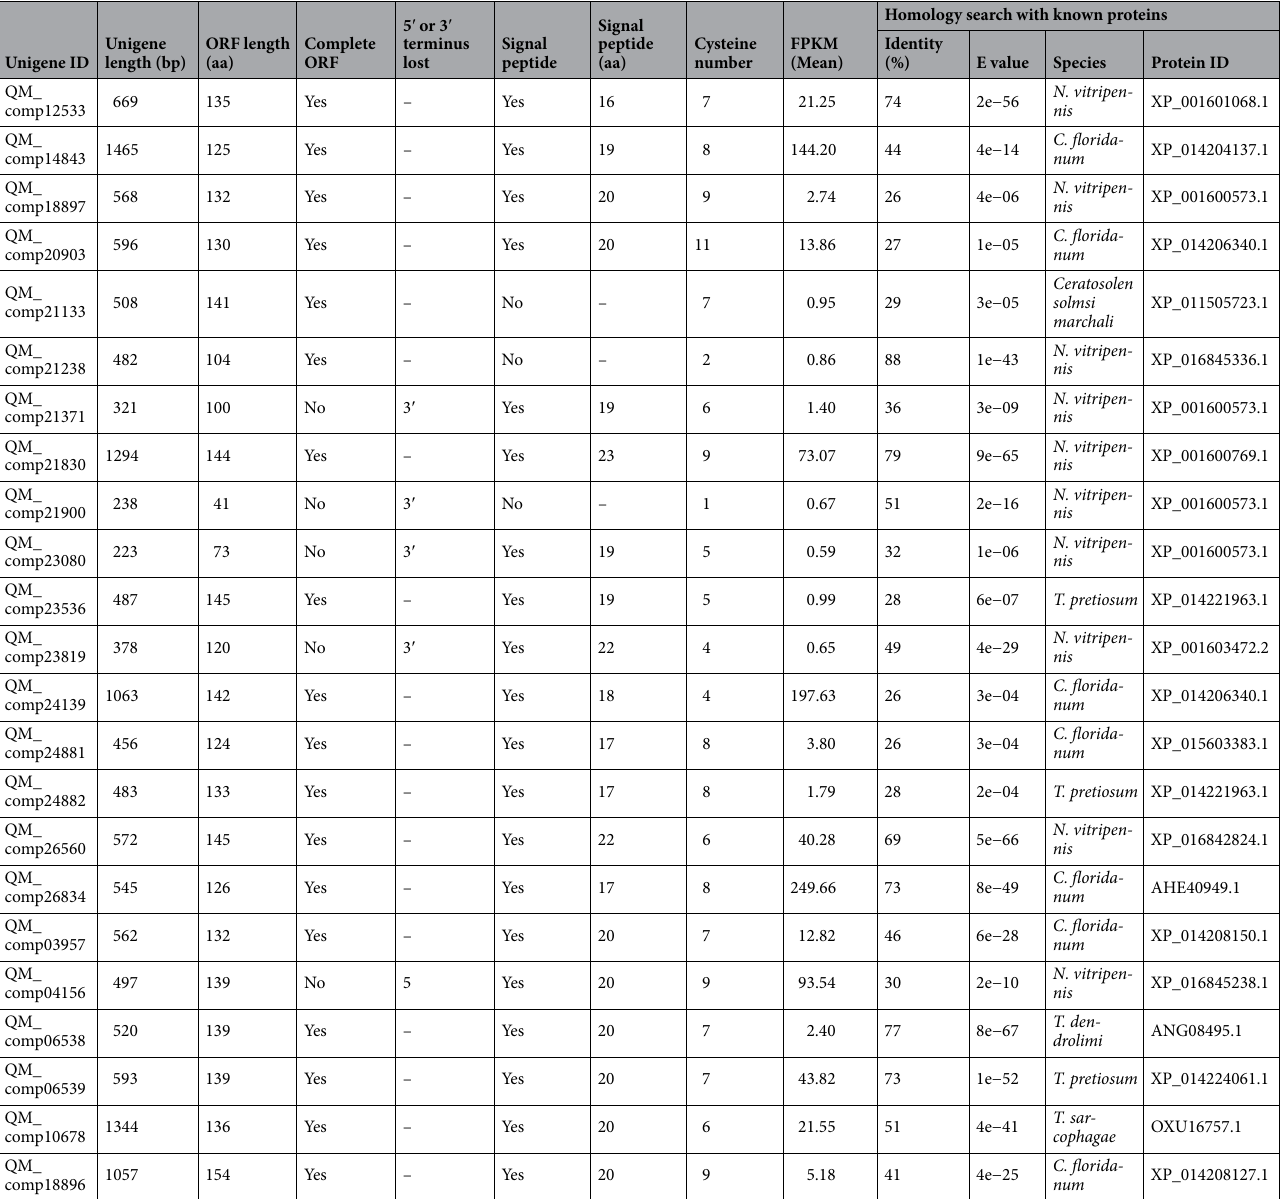
Table 4. Detailed information on the OBP ungenes of Quadrastichus mendeli